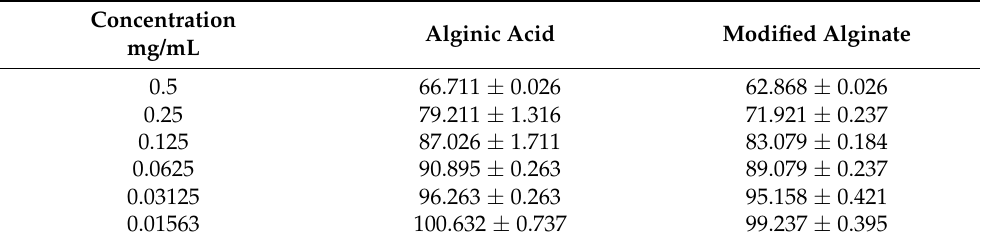
Table 2. Viability % of Wi-38 after 72 h exposure to alginate and aromatic alginate derivative.